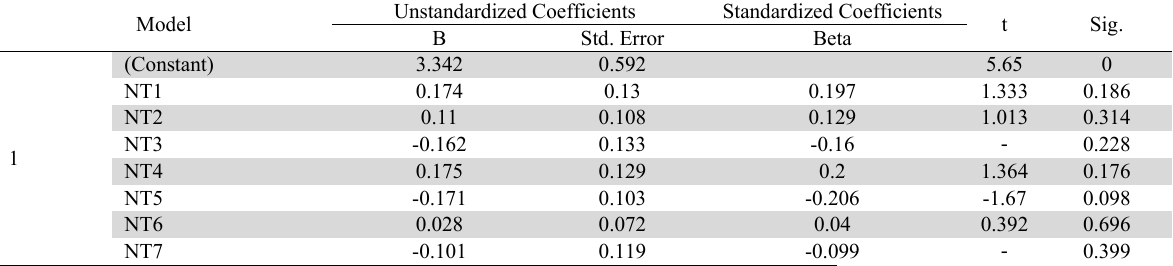
Regression analysis of factors affecting ROE Unstandardized Model